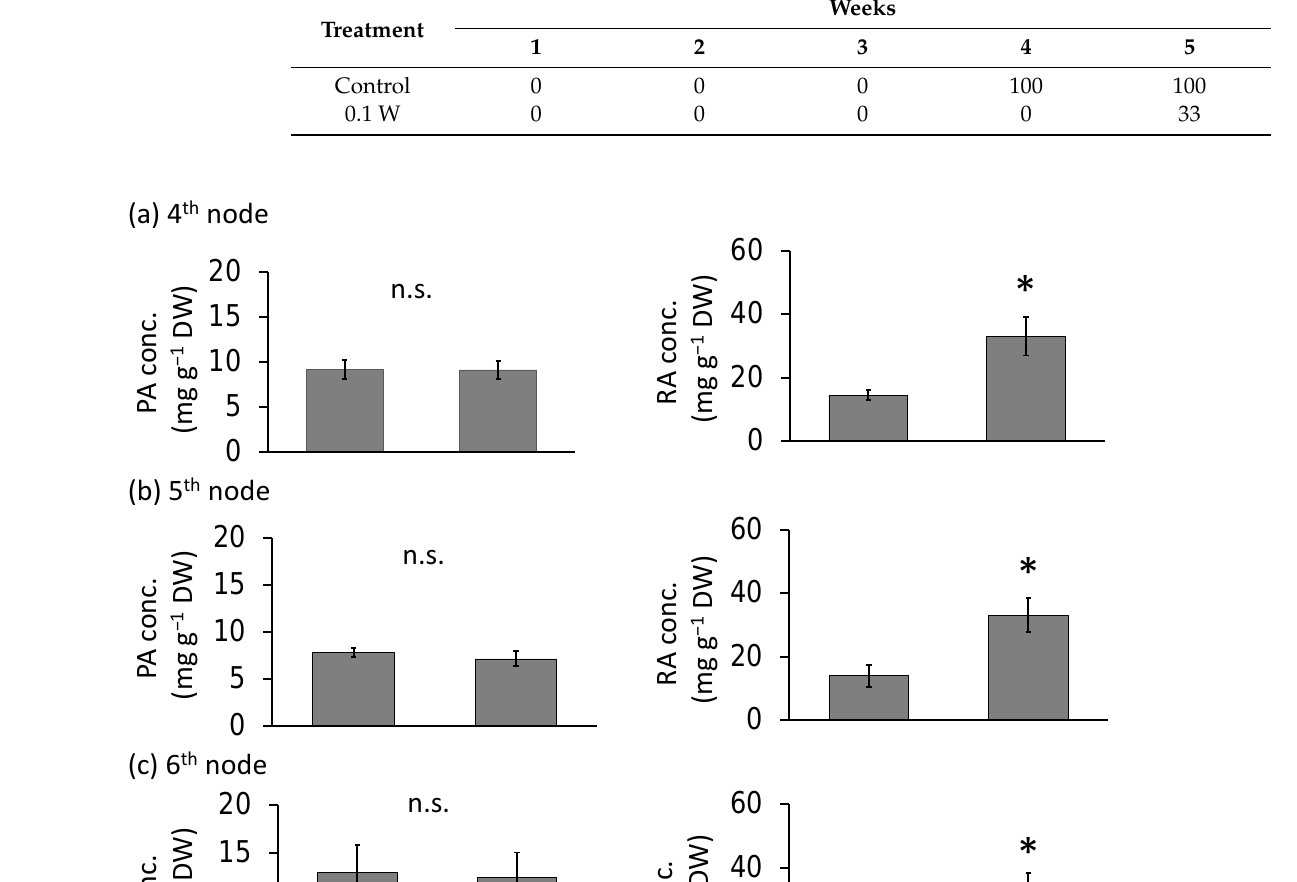
Table 1. Weekly percentage flowering of red perilla (Experiment 1, n = 6). The weekly percentage flowering was determined by dividing the number of plants that formed flower buds by the number of plants tested. Perilla plants were irradiated for 6 h from 23:00 to 05:00 h in a UV-B light treatment regimen. UV-B radiation intensity at the top of the plant canopy was set to 0.1 W m − 2 . Treatment